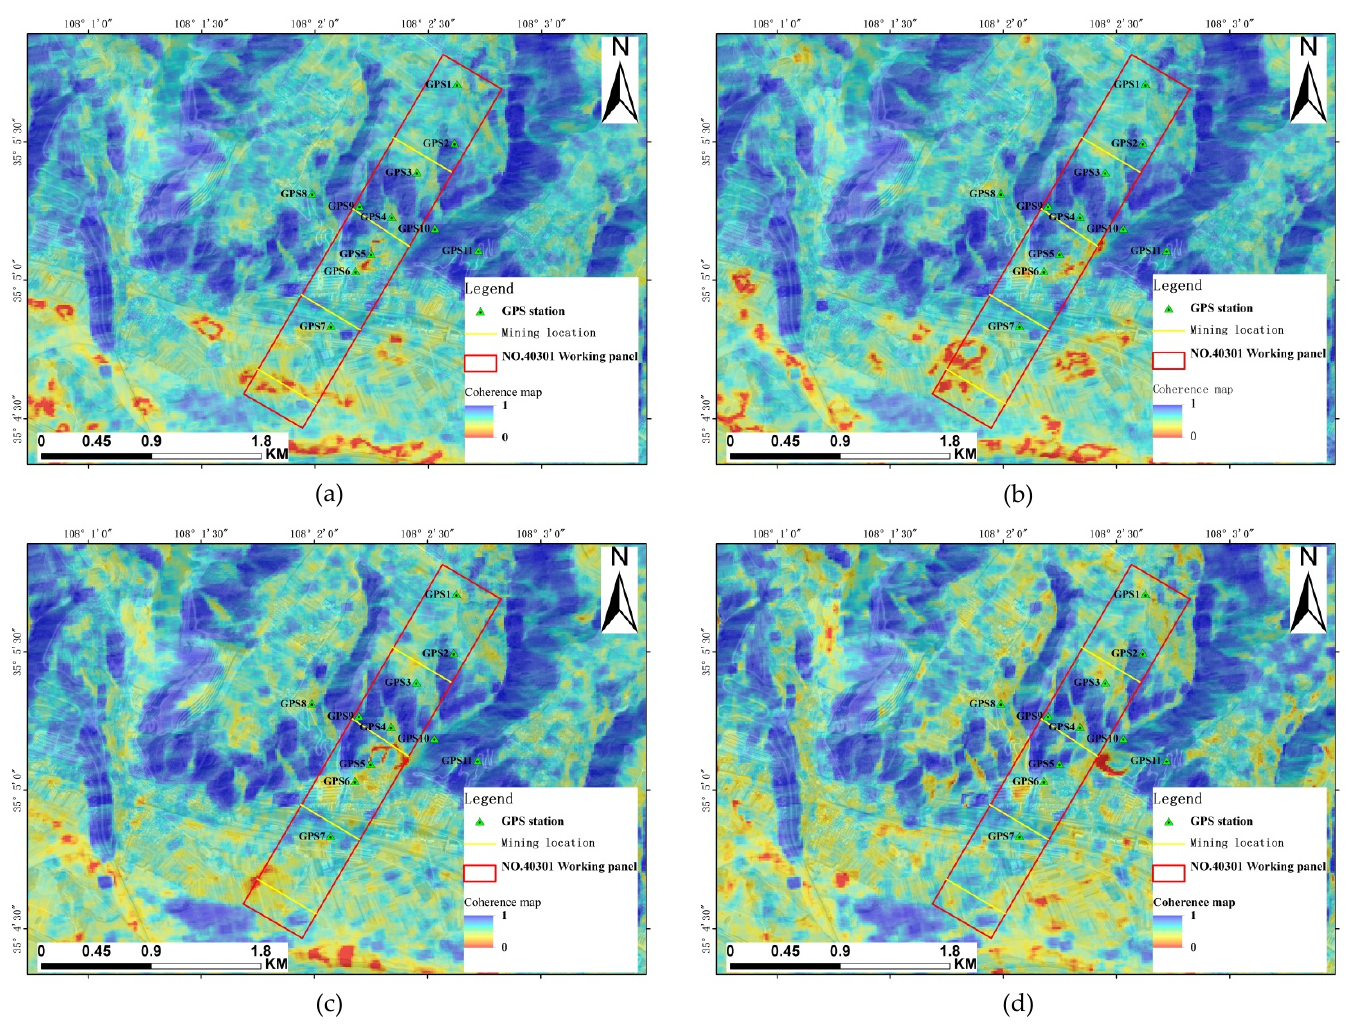
Figure 2. Di ff erential interferometric synthetic aperture radar (DInSAR) coherence maps: ( a ) the period from 4 July 2007 to 19 August 2007; ( b ) the period from 19 August 2007 to 4 October 2007; ( c ) the period from 4 October 2007 to 19 November 2007; and ( d ) the period from 19 November 2007 to 4 January